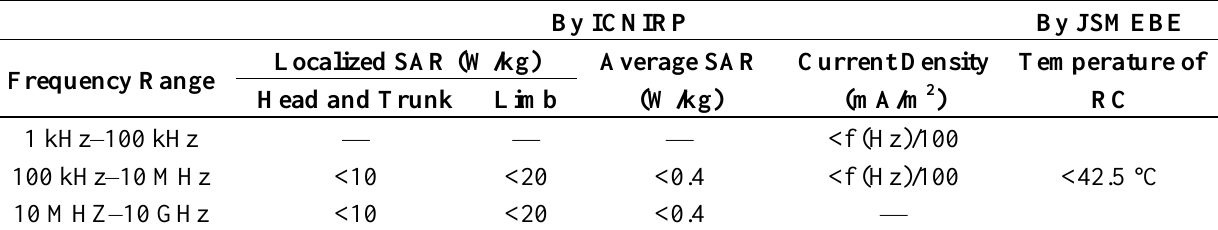
Table 3. Basic safety limitation for human body tissue by ICNIRP and